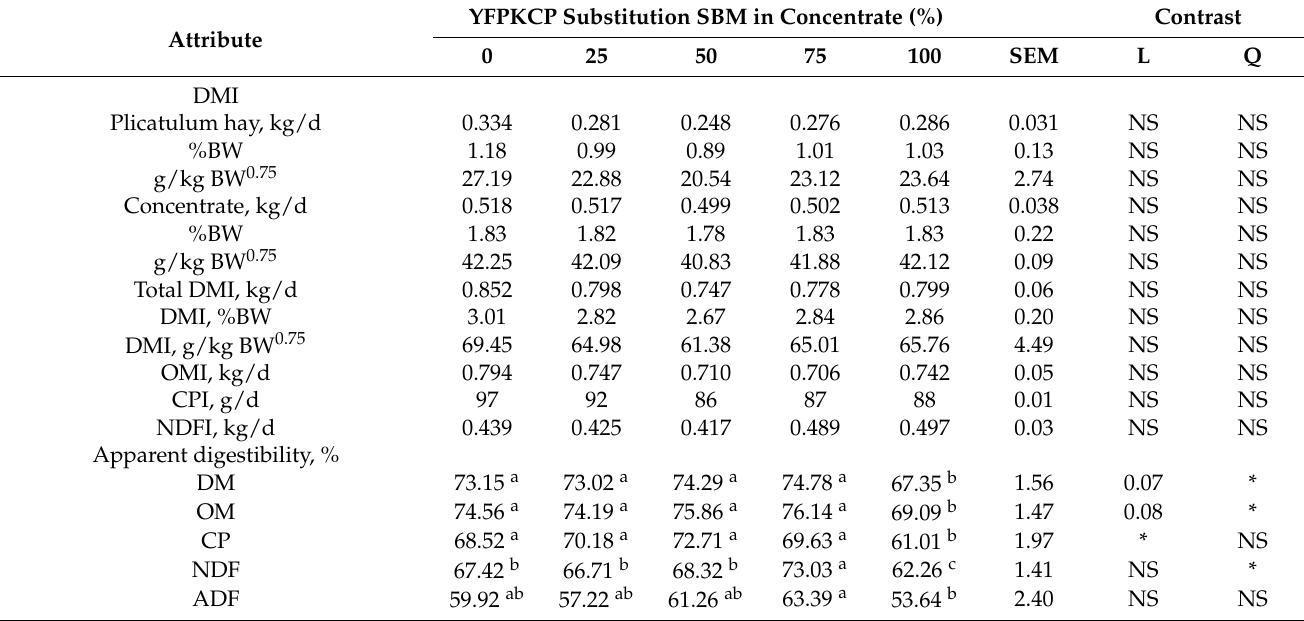
Table 3. Feed intake and apparent digestibility of fermented palm kernel cake in goats fed plicatulum hay as